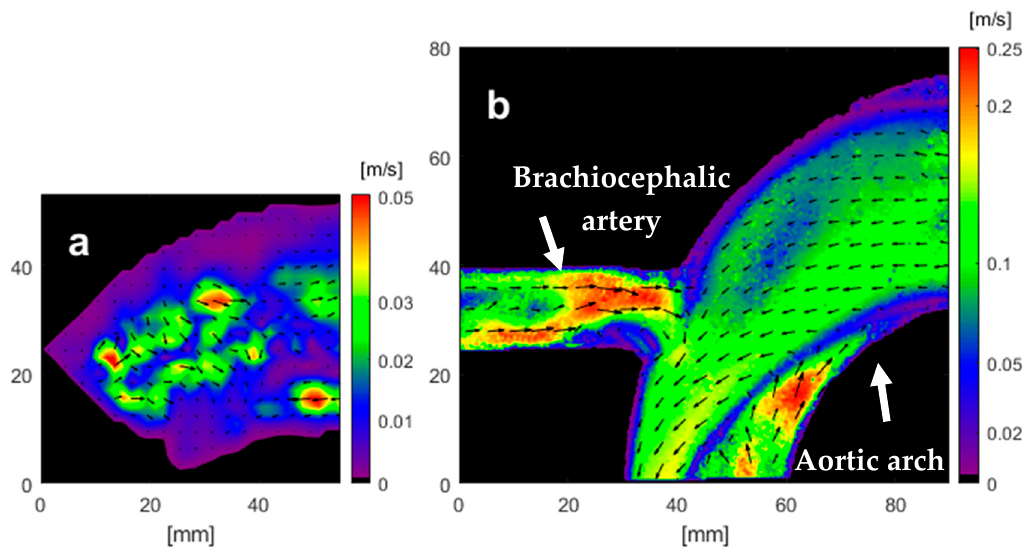
Figure 9. Indicative processed PIV images ( a ) initial phantom, ( b ); second phantom.